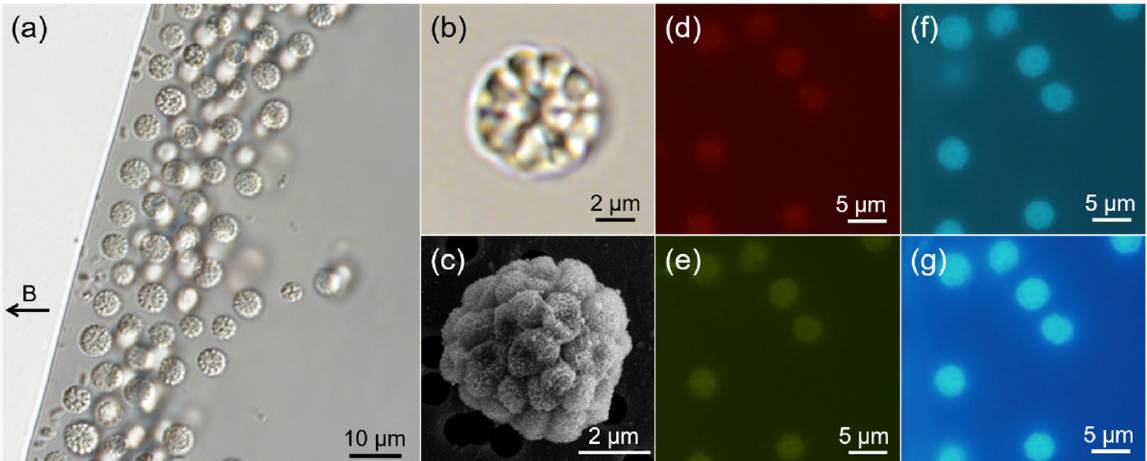
Figure 1. Abundance and morphology of spherical MMPs (sMMPs) from Jinsha Bay. ( a ) The sMMPs aligned to the magnetic field lines. The black arrow to the left indicates the direction of the magnetic field. Differential interference contrast image ( b ) and scanning electron micrograph ( c ) of representative sMMPs. Fluorescence images of living sMMPs illuminated by green light ( d ), blue light ( e ), violet light ( f ), and UV light ( g ).